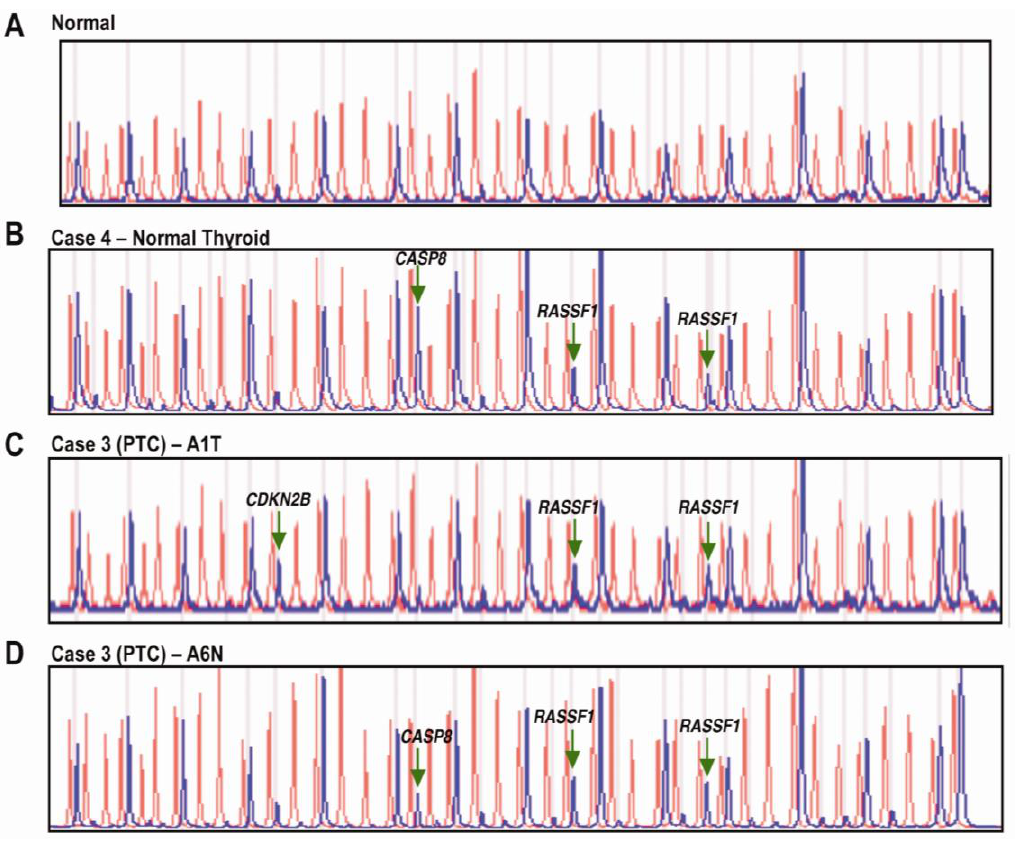
block) with methylation of CDKN2B and RASSF1 . ( D ) Papillary thyroid cancer (Case 3 - normal block) with methylation of CASP8 and RASSF1 . (PTC – papillary thyroid